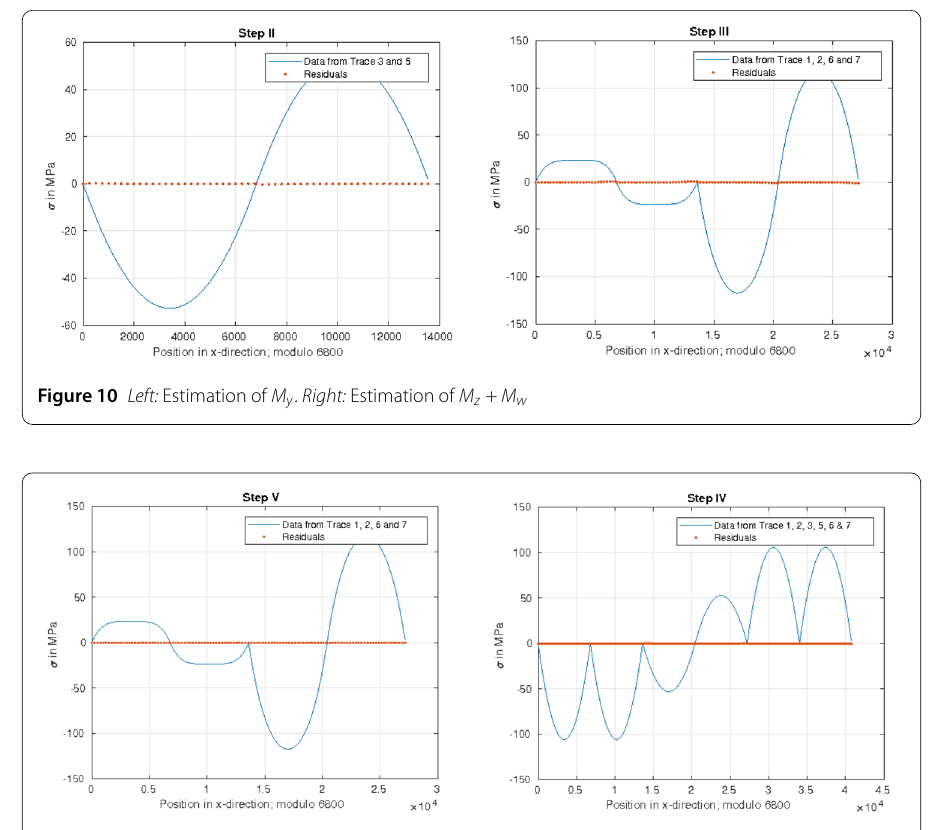
Algorithm First, normalise all observations, i.e. remove the constants c = ( c 1 ,..., c 7 ),